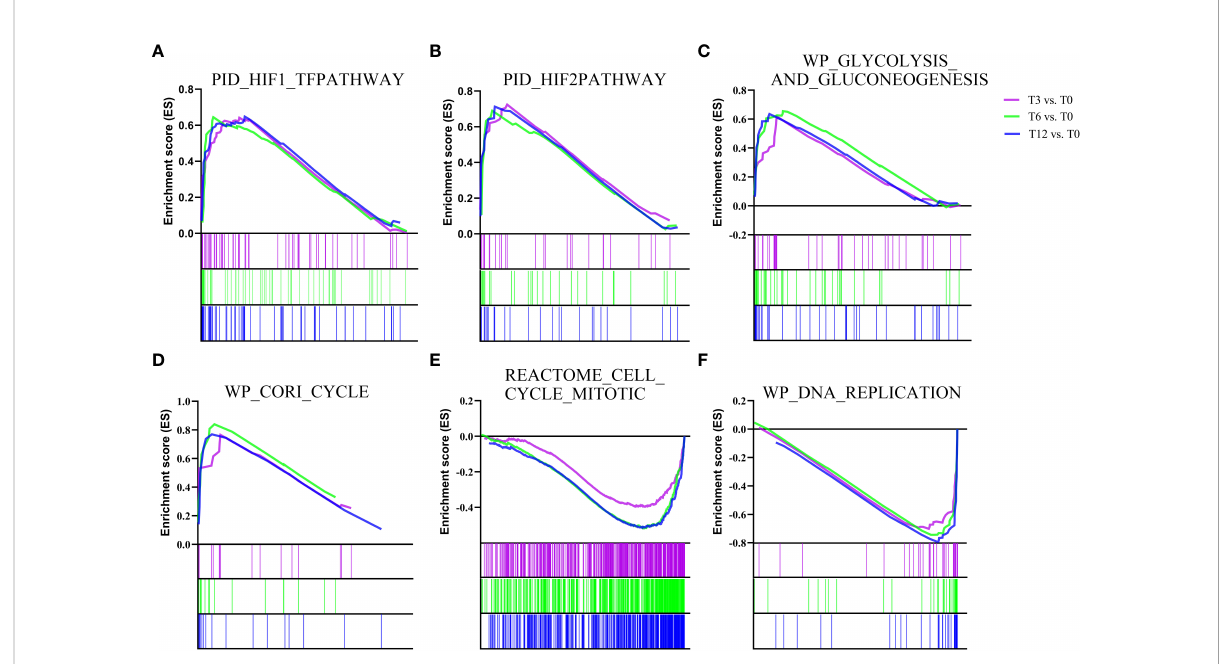
FIGURE 2 Gene Set Enrichment analysis (GSEA) plots showing the most enriched gene sets in hypoxia treatment groups (T3, T6 and T12) and control group (T0). The most signi fi cant enriched gene sets positively correlated with hypoxia treatment groups (T3, T6 and T12) are (A) PID_HIF1_TFPATHWAY, (B) PID_HIF2PATHWAY, (C) WP_GLYCOLYSIS_AND_GLUCONEOGENESIS, and (D) WP_CORI_CYCLE. The most signi fi cant enriched gene sets positively correlated with control group (T0) are (E) REACTOME_CELL_CYCLE_MITOTIC and (F) WP_DNA_REPLICATION. The enrichment score of each comparison is showed with different color